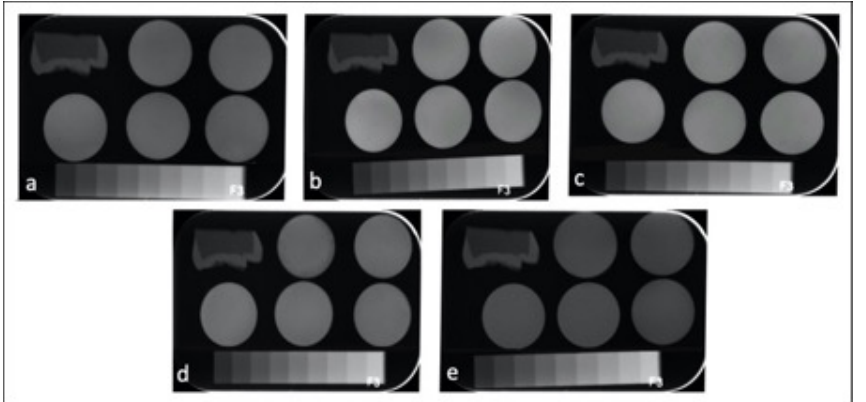
Figure 1. Radiographic images of the enamel, dentin, aluminum stepwedge and universal CRs: ( a ) GA; ( b ) CD; ( c ) NS; ( d ) F; ( e ) EA.